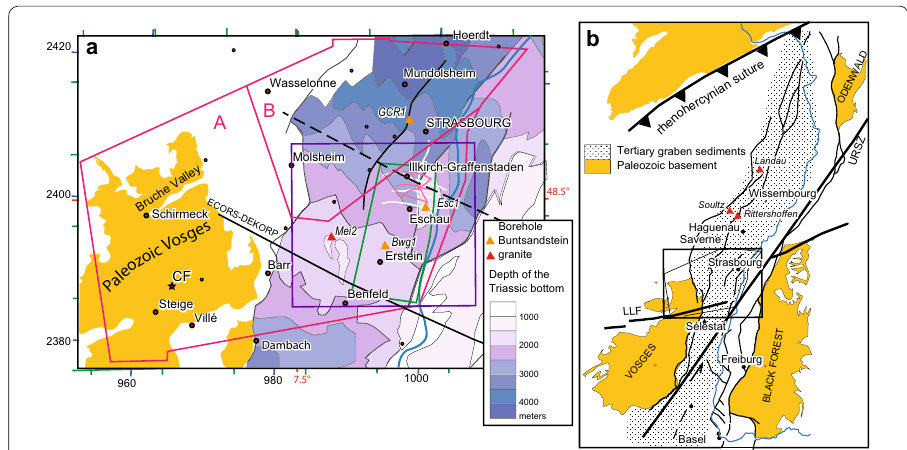
Fig. 1 a Outcrop of the Northern Palaeozoic Vosges and isobaths map of the Triassic bottom derived from the interpretation of seismic sections (after Ménard 1979). Red contour: limits of the new aeromagnetic map. The A zone is shown in this paper. The B zone is completed by the magnetic data at ground level by Edel et al. (1982). Green contour: limits of the additional gravimetric data. Violet contour: location of the detailed maps given in Fig. 8. Location of the seismic sections in the area of the geothermal project: old lines in white, new ones in red. Mei2 is the sole borehole that has cored the granitic basement. Coordinates: Lat/Long in red, Lambert II extended in blue, UTM zone 32 N in green. b Location of the investigated area in the upper Rhinegraben. CF: Champ du Feu; URSZ: Upper-Rhine Shear Zone (Edel et al. 2007). The dashed line in a locates the temperature section of Fig.